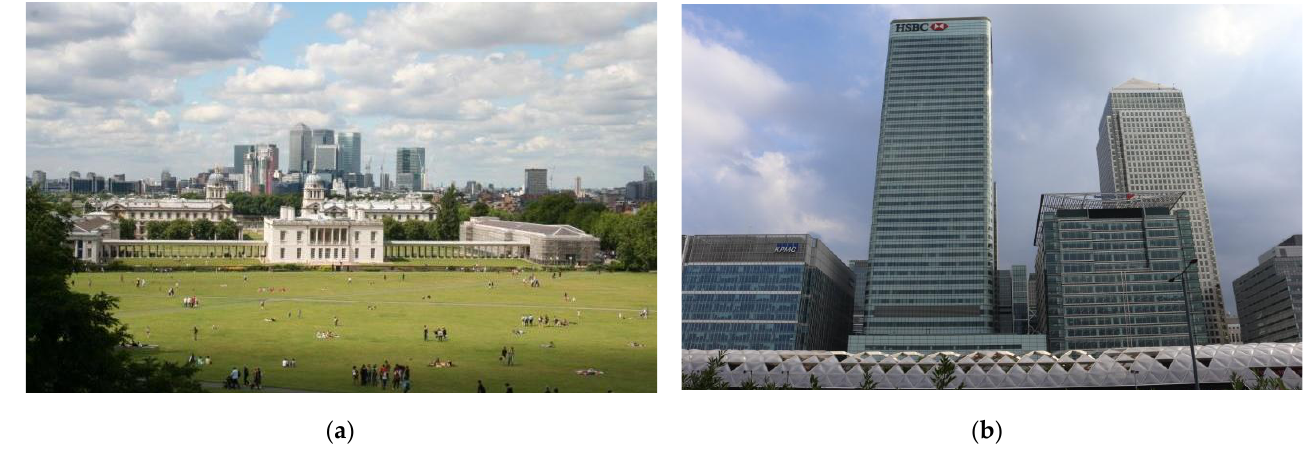
Figure 3. The historic views of Canary Wharf office towers. ( a ) Canary Wharf’s skyline viewed from the south, Maritime Greenwich World Heritage Site (2007); ( b ) Canary Wharf’s skyline viewed from the north, Poplar DLR station (2017).